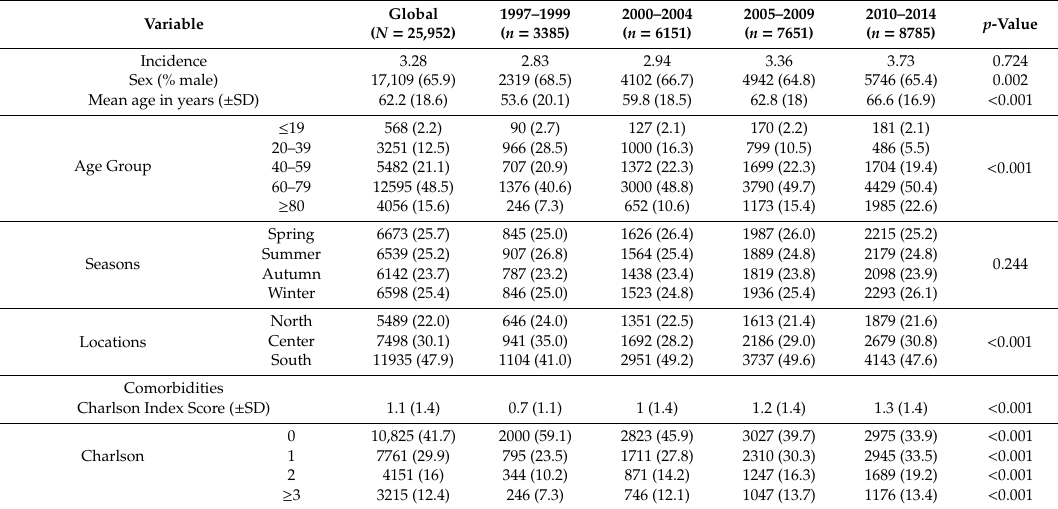
Table 1. Patient characteristics of infective endocarditis in Spain from 1997 to 2014. Overall and trends by year.